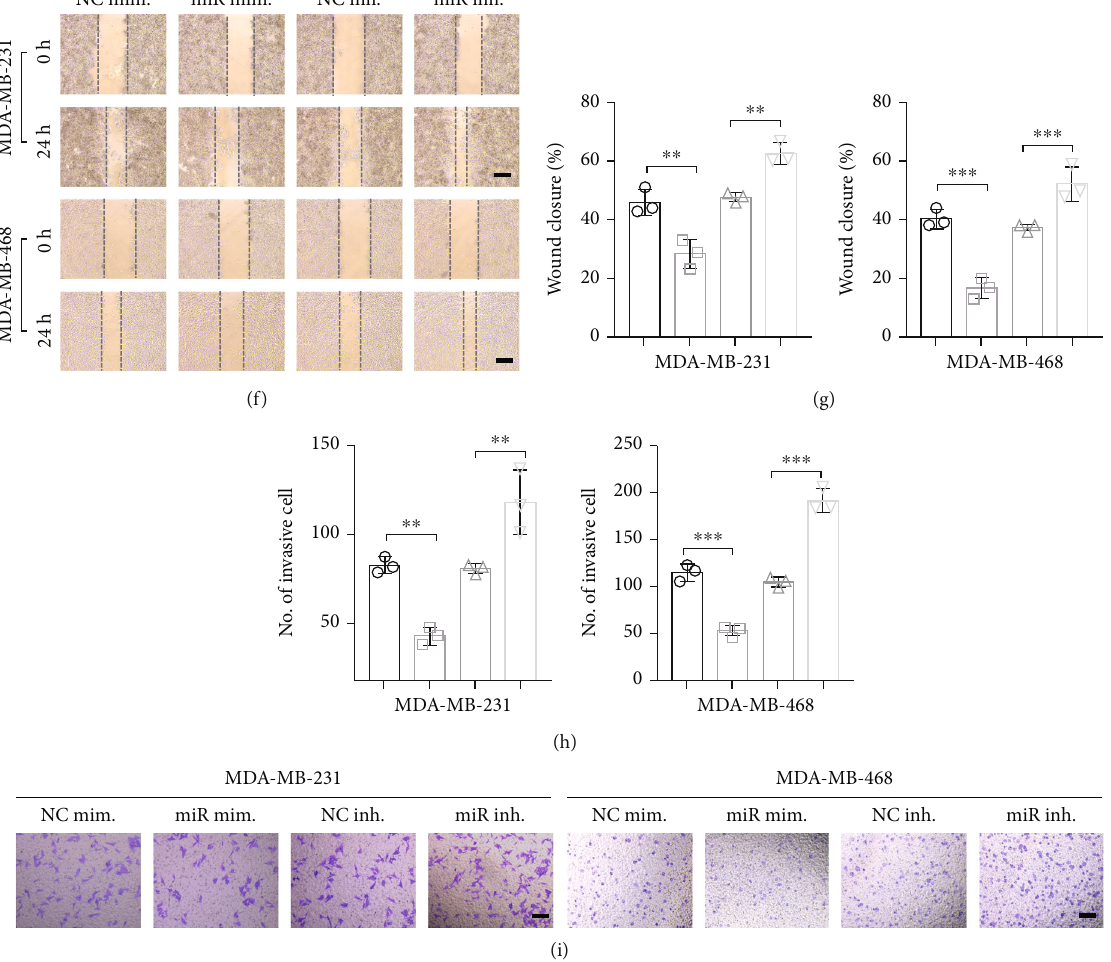
Figure 4: miR-6745 regulated by LINC01574 inhibited BC cell proliferation, migration, and invasion. (a) The mRNA level of miR-6745, miR-633-5p, and miR-4291 was detected by qRT-PCR. (b, c) Relative expression of miR-6745 in BC cell tumor tissues. (d) After WT- LINC01574 or MUT-LINC01574 were cotransfected with miR-6745 mimics, the relative luciferase activity was evaluated. (e – i) After corresponding transfection, the proliferation, migration, and invasion abilities were detected. ∗ P < 0 : 05 , ∗∗ P < 0 : 01 , and ∗∗∗ P < 0 : 001